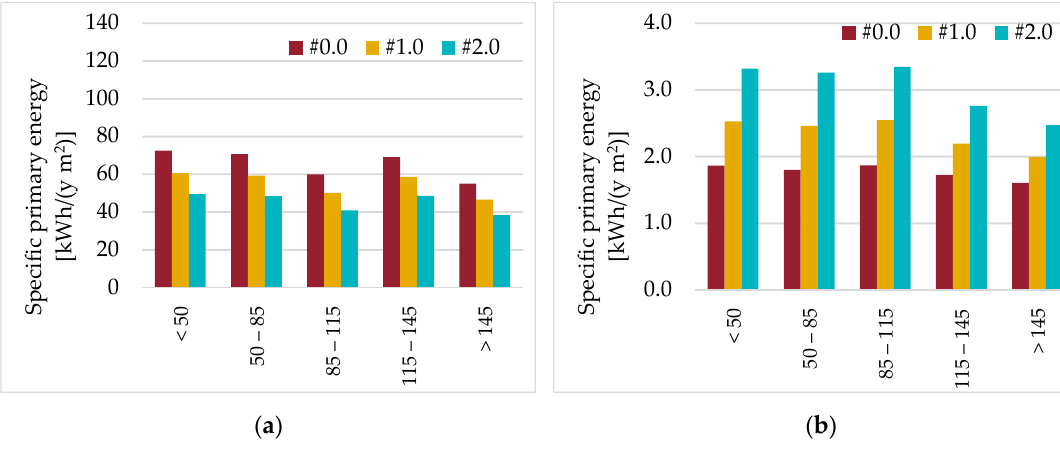
Figure 12. Rome: Specific primary energy consumption. ( a ) Heating; ( b ) cooling.